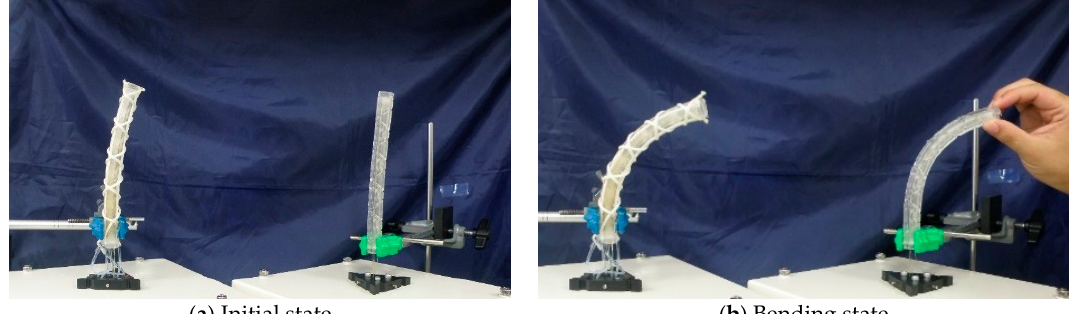
Figure 12. Performance of the master-slave control: ( a ) Initial state. ( b ) Bending state.